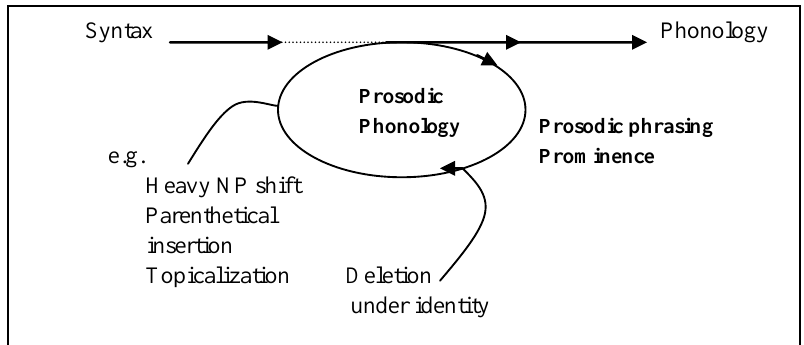
Figure 1. A view of the syntax-phonology